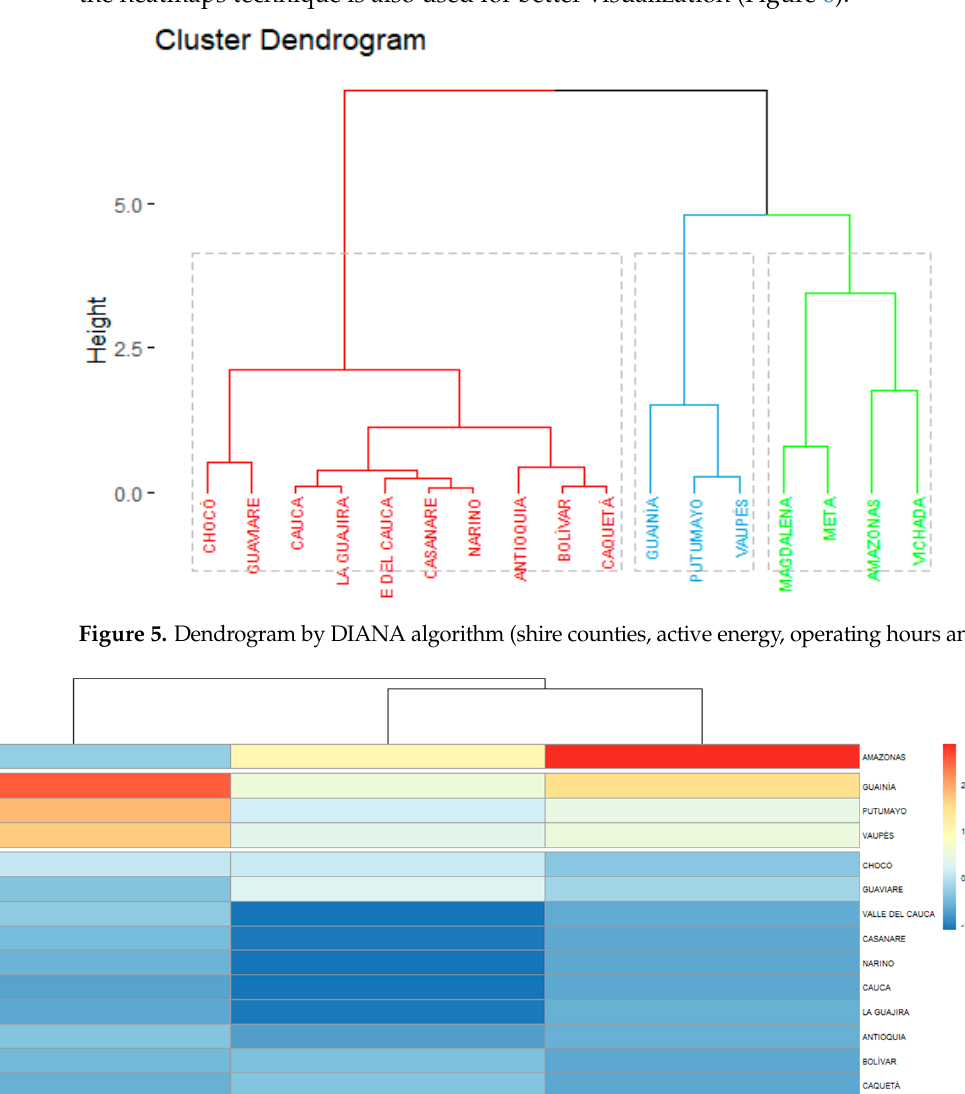
( b ) Figure 4. ( a ) Optimal number of clusters; ( b ) clusters by K-medoids algorithm (shire counties, active energy, operating hours, and power). Table 4. Representative means of shire counties clusters by K-medoids.